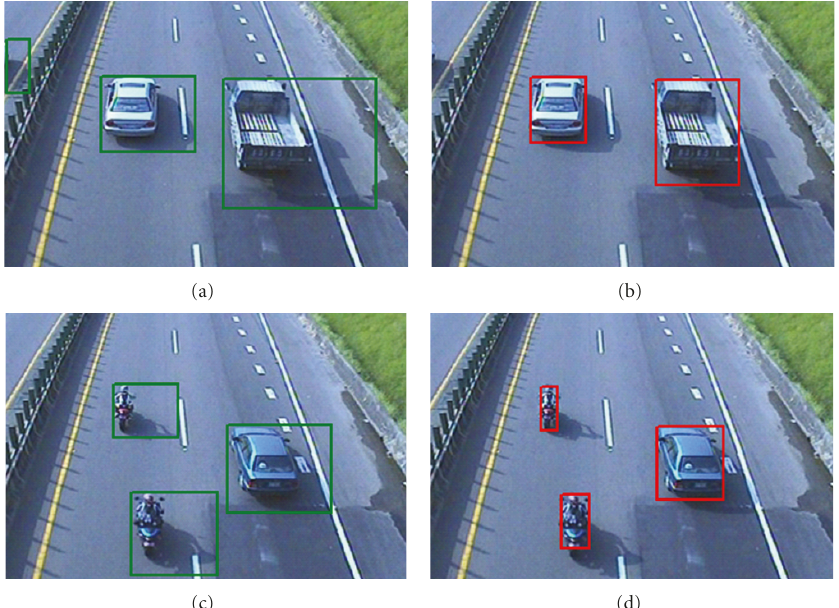
Figure 28: Experimental results of foreground object detection.